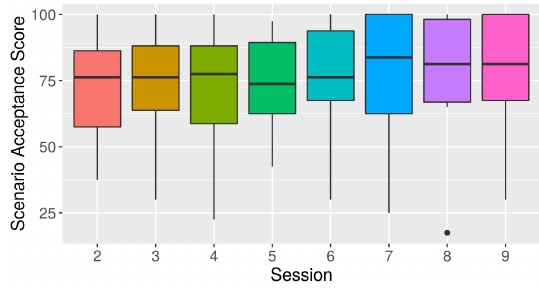
Figure 6: Responses to Global Evaluation measures across sessions for Scenario Acceptance.